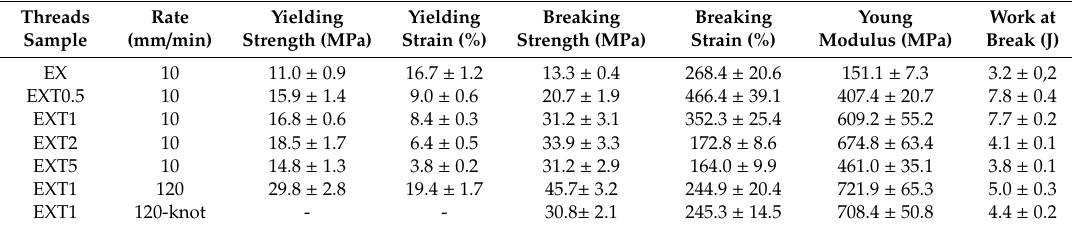
Table 3. The tensile static mechanical test results of all the extruded